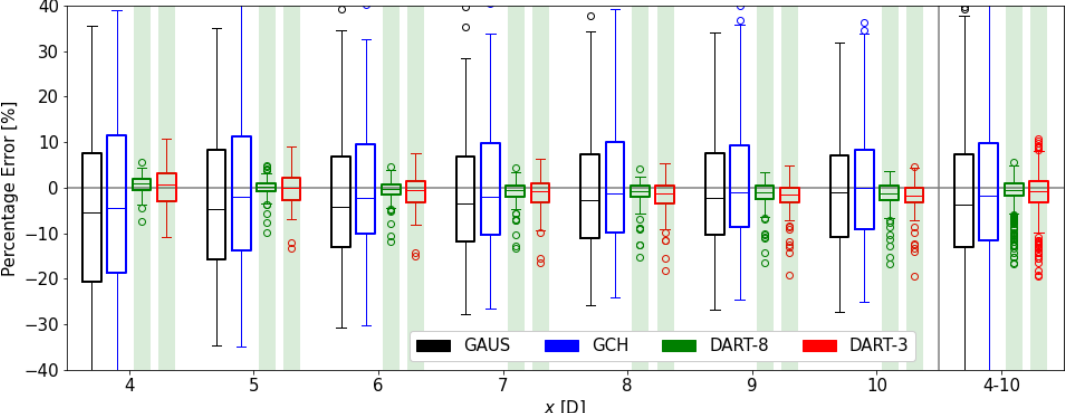
Figure 7. Performance of all models on training data displayed as percentage error in available power. In black GAUS, in blue GCH, in green DART-8 and in red DART-3. The boxes on the far right (labeled 4–10) include all simulations and all distances. The shaded areas indicate a significant improvement (green), insignificant difference (yellow) or significant decline (red) in the accuracy of DART compared to the benchmark models.